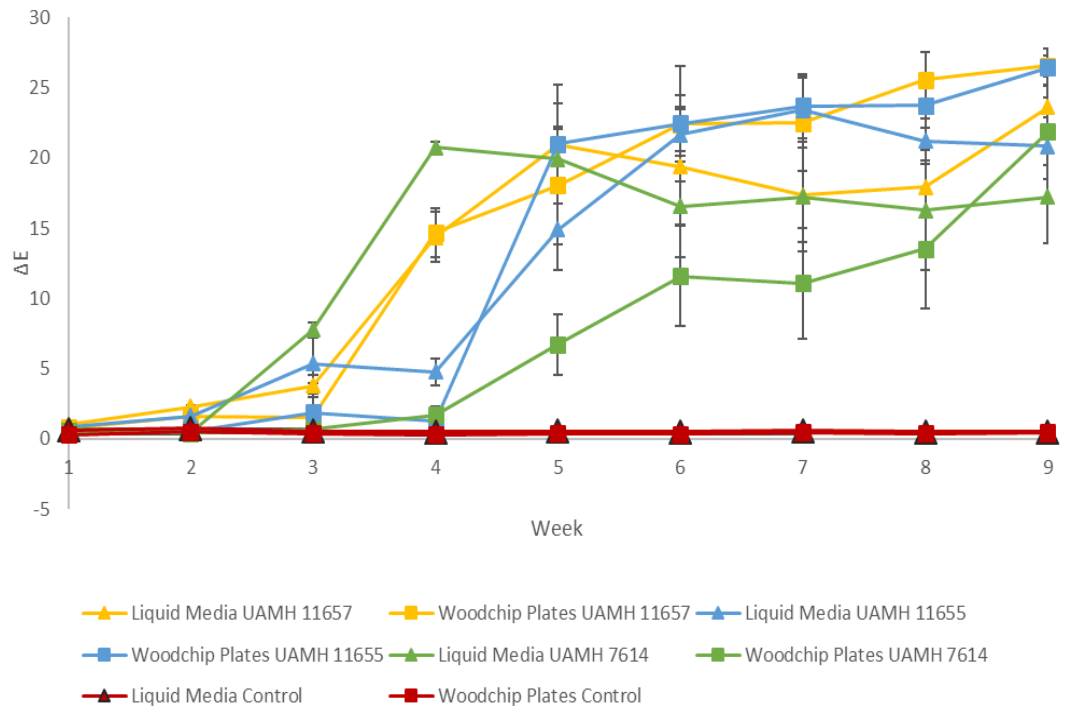
Figure 3. Differences in color (∆E) produced by Chlorociboria sp. over 9 weeks growth. Strain UAMH 11657 was Chlorociboria aeruginosa , and strains UAMH 11655 and UAMH 7614 were Chlorociboria aeruginascens. Error bars represent one standard error. A significant difference was seen for the interaction between growth substrate (liquid media vs. woodchip), week, and fungal strain ((df = 27, 144), F = 47.93, p < 0.0001). No significant differences were seen after week 5 in ∆E between fungal cultures.